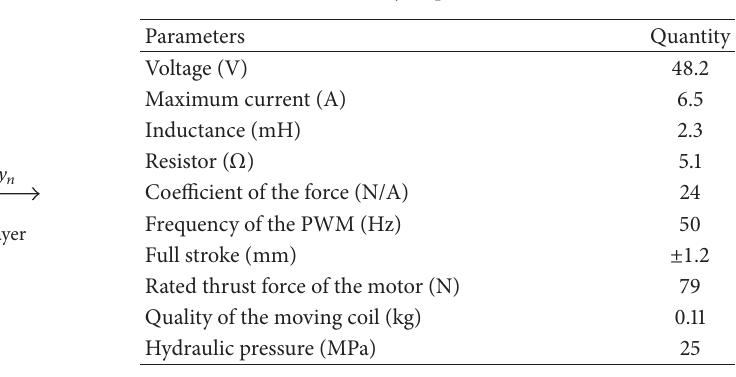
Table 1: Major specification